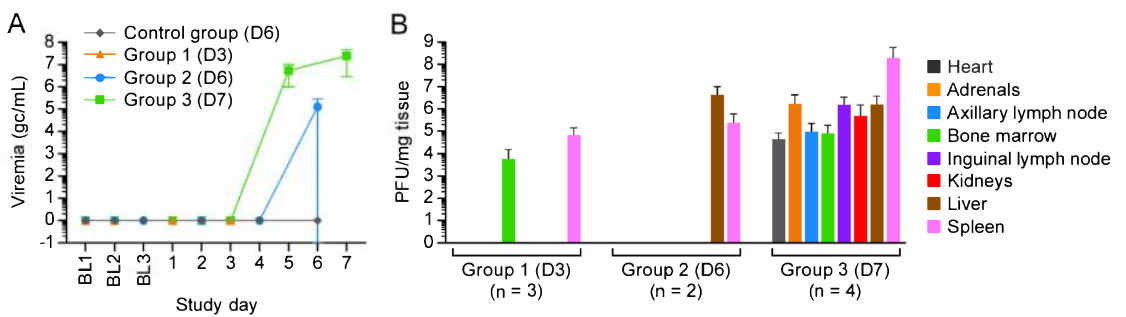
Figure 2. Viremia and tissue virus loads indicate early infection of the bone marrow and spleen. ( A ) Viremia was observed at Day 5 post-exposure. ( B ) Tissue viral load suggests early infection of the spleen and bone marrow. BL = baseline sampling, time points prior to intravenous (IV) cowpox virus (CPXV) exposure. Bars indicate standard deviation. Day 0 is not included on the graphs because no measurements were made.